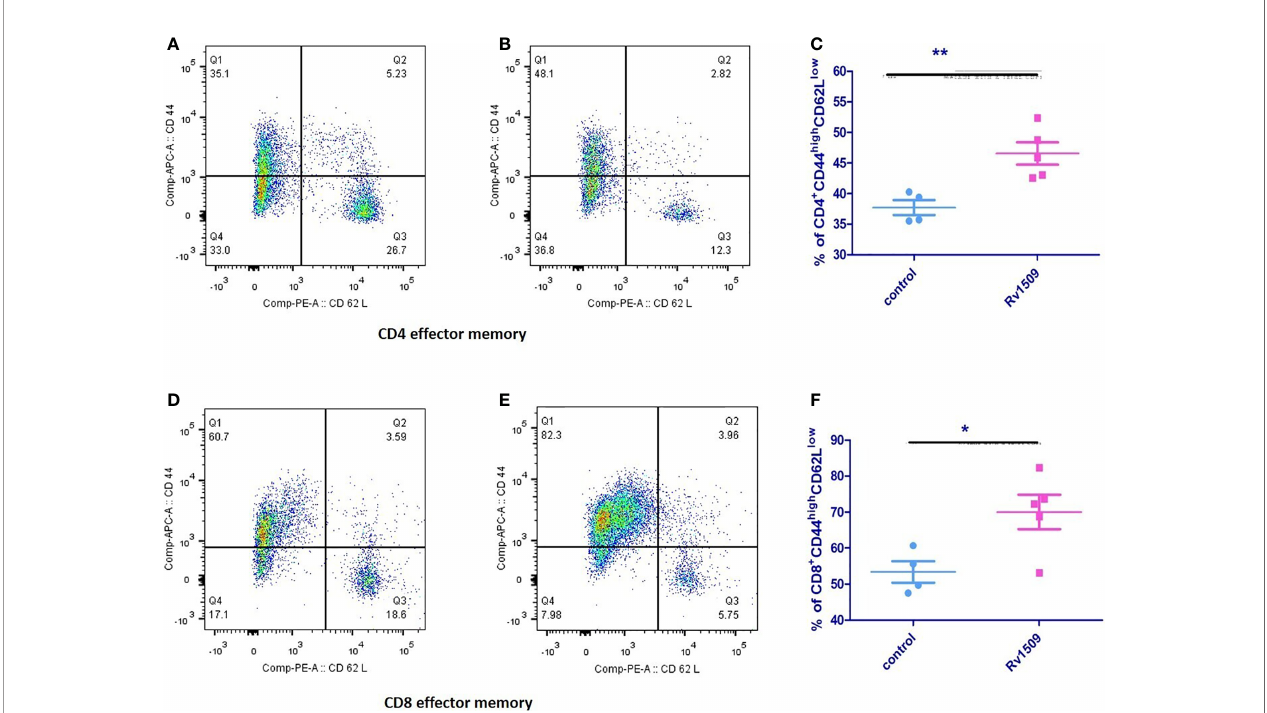
FIGURE 6 | Rv1509 protein enhances effector memory cells in immunized mice. Mice (n = 5) were immunized with recombinant Rv1509 protein. Splenocytes from immunized mice were stimulated in vitro with rRv1509 overnight and stained with antibodies against CD3, CD4, CD8 CD44 and CD62L.Lymphocyte cells were selected and gated for CD3 population followed by CD4 and CD8 selection by double gating strategy. From CD4 and CD8 population gating was performed to identify cells expressing CD44 and CD62L. Both CD4+ and CD8+ effector memory cells (CD44 high CD62L low ) were increased after immunization with Rv1509 antigen. Note the enhanced number of CD4+ (A – C) and CD8+ (D – F) effector memory cells in mice immunized with Rv1509 protein antigen compared to control. Representative data are from fi ve samples in each group from a single experiment representative of two experiments. (The data are expressed as mean ± SD). *p < 0.05 and **p <